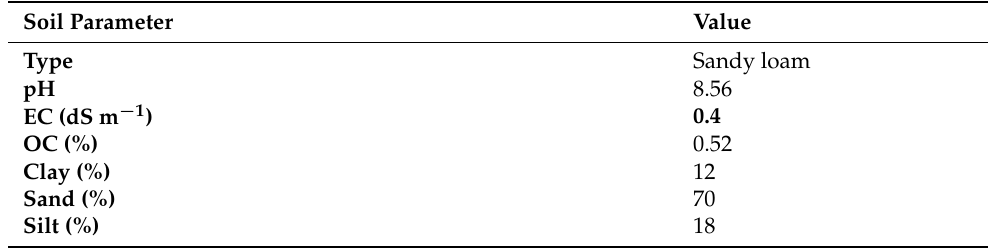
Table 1. Physical and chemical characteristics of the soil sampled from the experimental site. Soil